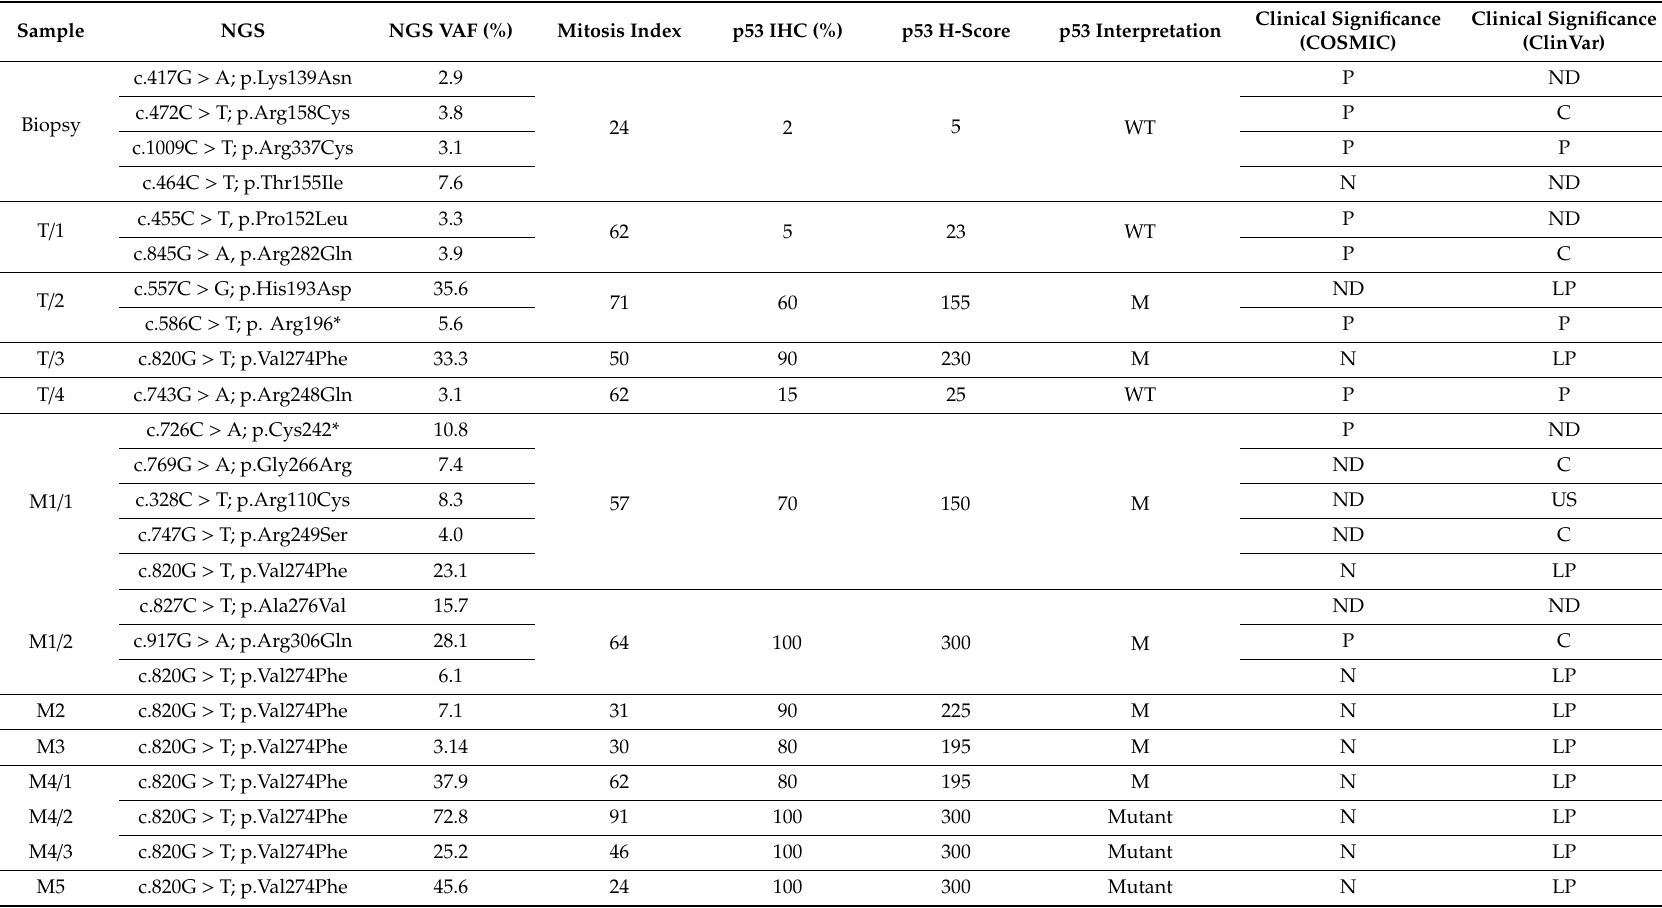
Table 3. TP53 sequencing, p53 immunohistochemistry and cell proliferation data obtained from the same tumor tissue sample. WT = wild-type, M = mutant type, P = pathogenic, N = neutral, ND = not detected, C = conflicting interpretation of pathogenicity, US = uncertain significance, LP = likely